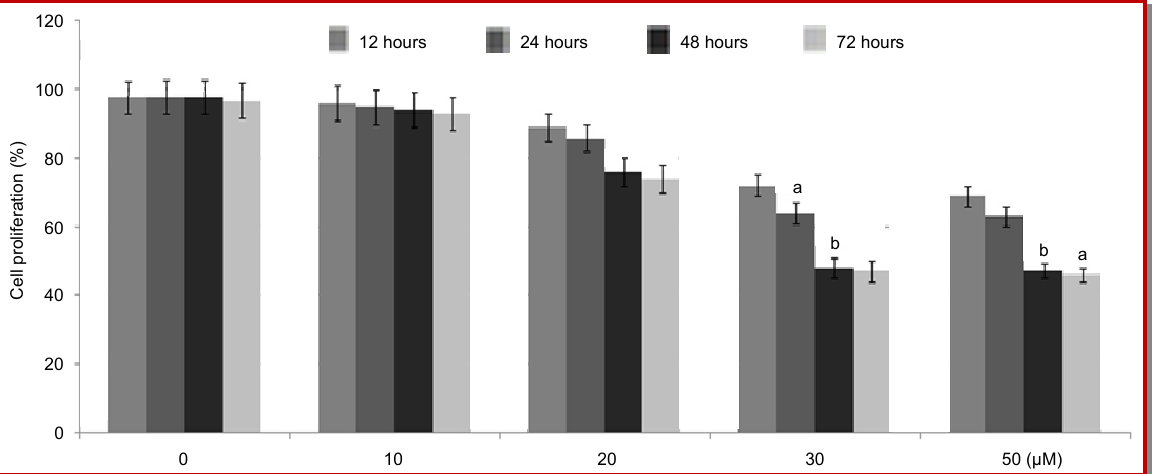
Figure 1: Reduction in the rate of proliferation in OVCAR5 cells by treatment with ludartin for 24, 48 and 72 hours. The effect of ludartin on proliferation rate of OVCAR5 cells was analyzed by MTT assay. The results expressed are the mean ± SEM. a p<0.05 compared with the